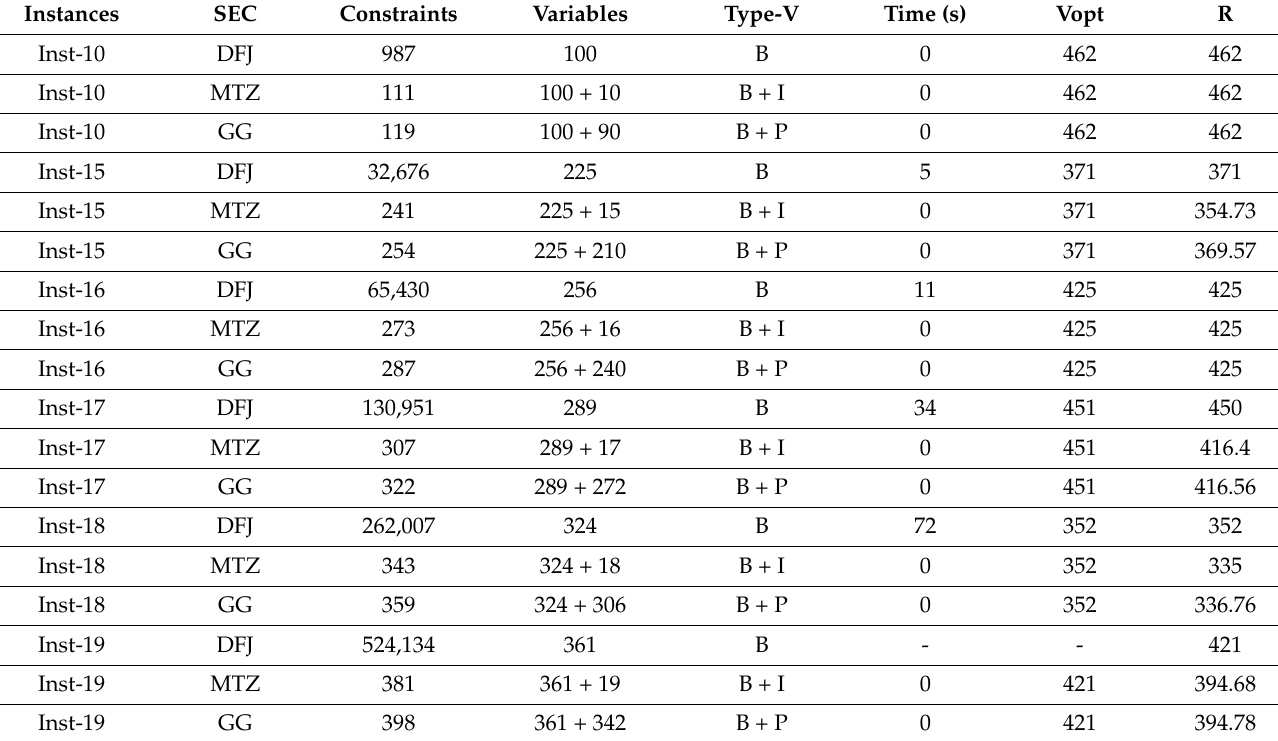
Table 3. Results reported by